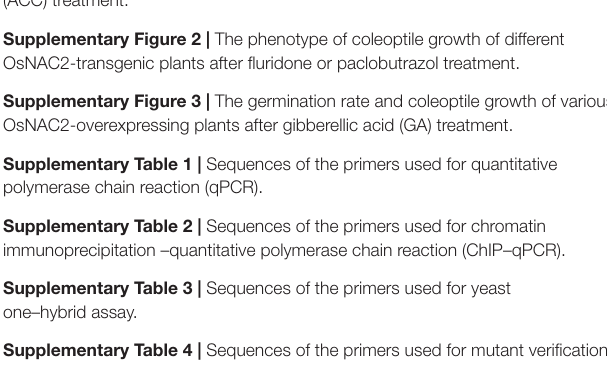
Supplementary Table 3 | Sequences of the primers used for yeast one–hybrid assay. Supplementary Table 4 | Sequences of the primers used for mutant